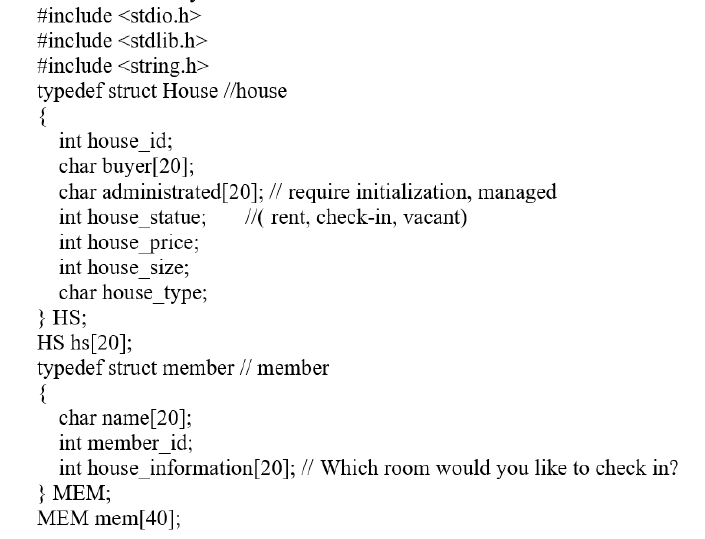
Fig. 4. Array functions in software